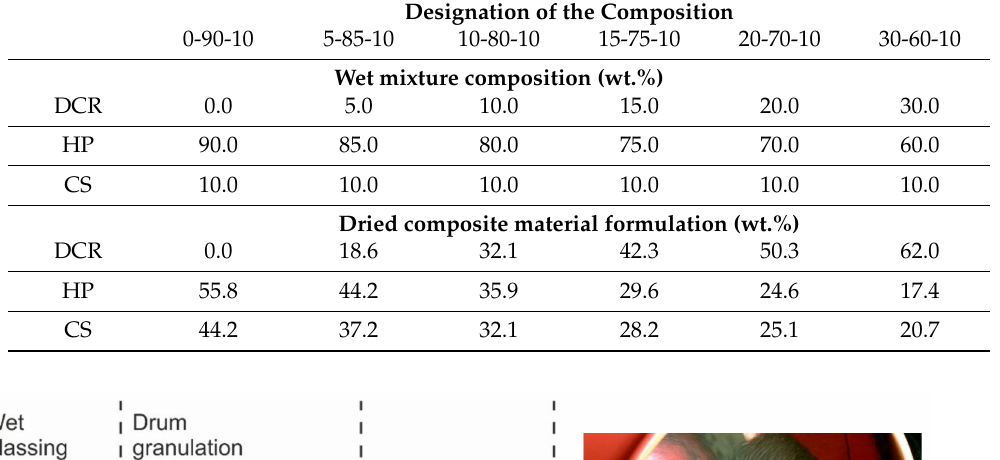
Table 3. The composition of block and granules in the raw mixture (wet) and after drying by wt.% (part II) [4].